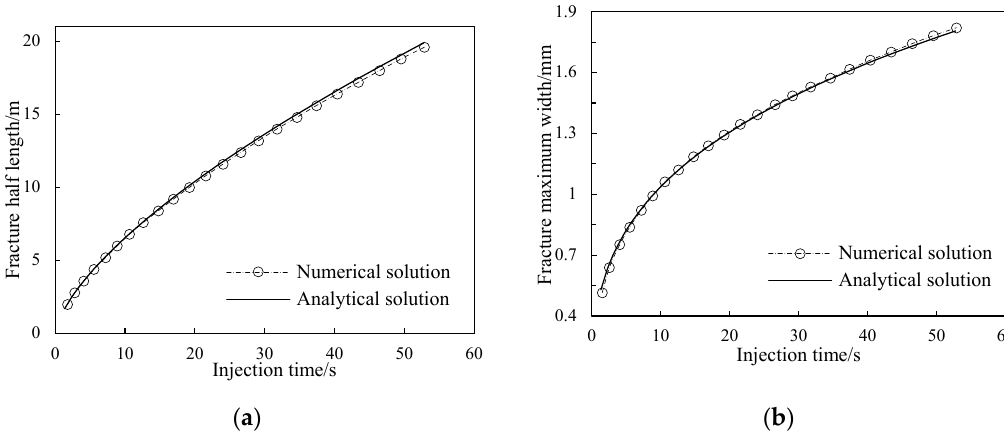
Figure 5. Analytical and numerical results. ( a ) Fracture half length, and( b ) fracture maximum width.